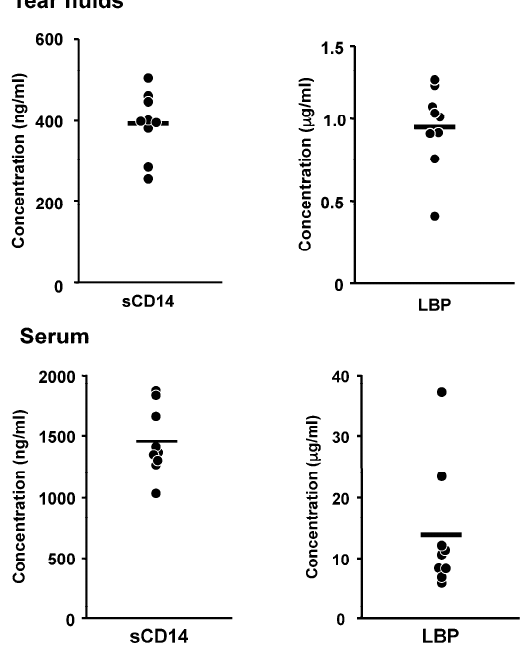
Figure 3. Concentrations of sCD14 and LBP in human tear fluid and serum from the same individuals. Circles, individual values; bars, mean values. Reprinted with permission from [31].